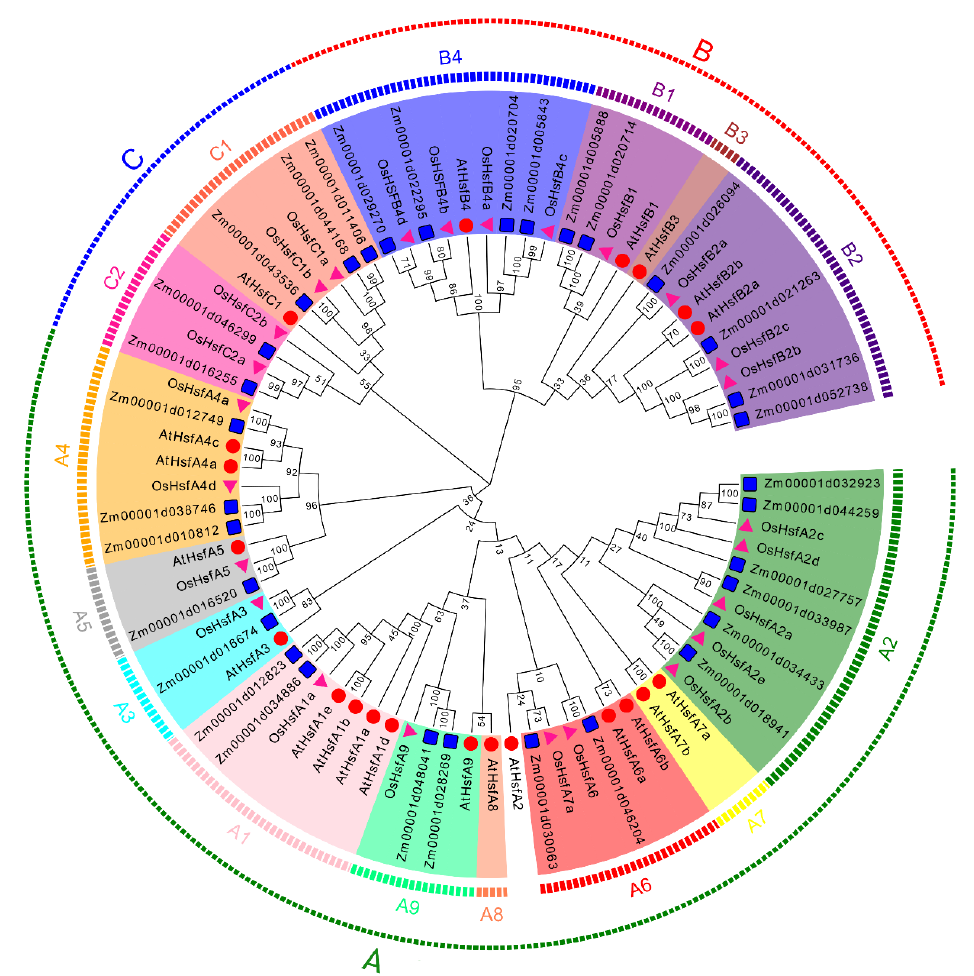
Figure 1. Complex phylogenetic tree of Hsf proteins in rice ( Oryza sativa L. Os), Arabidopsis ( Ara- bidopsis thaliana L. At), and maize ( Zea mays L. Zm). The tree was generated using the protein sequences of rice (pink triangle), Arabidopsis (red circle), and maize (blue square). The tree shows three major groups (A – C) and 15 subgroups with different colored backgrounds.